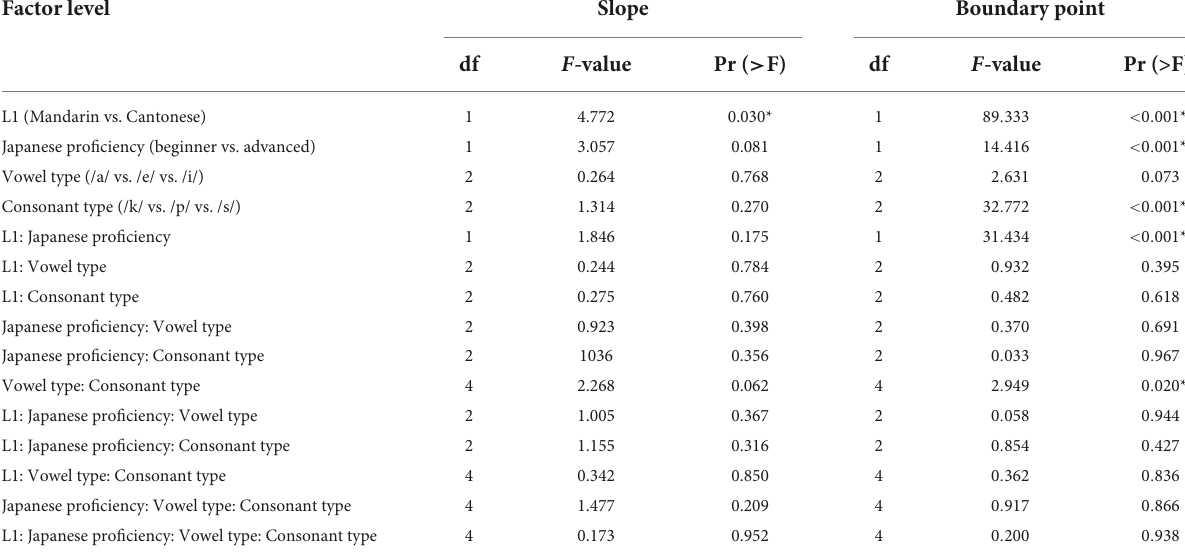
TABLE 5 The MANOVA summary: ‘Slope + boundary point’ ∼ L1 * Japanese proficiency * vowel types * consonant types. Factor level Slope Boundary point df F